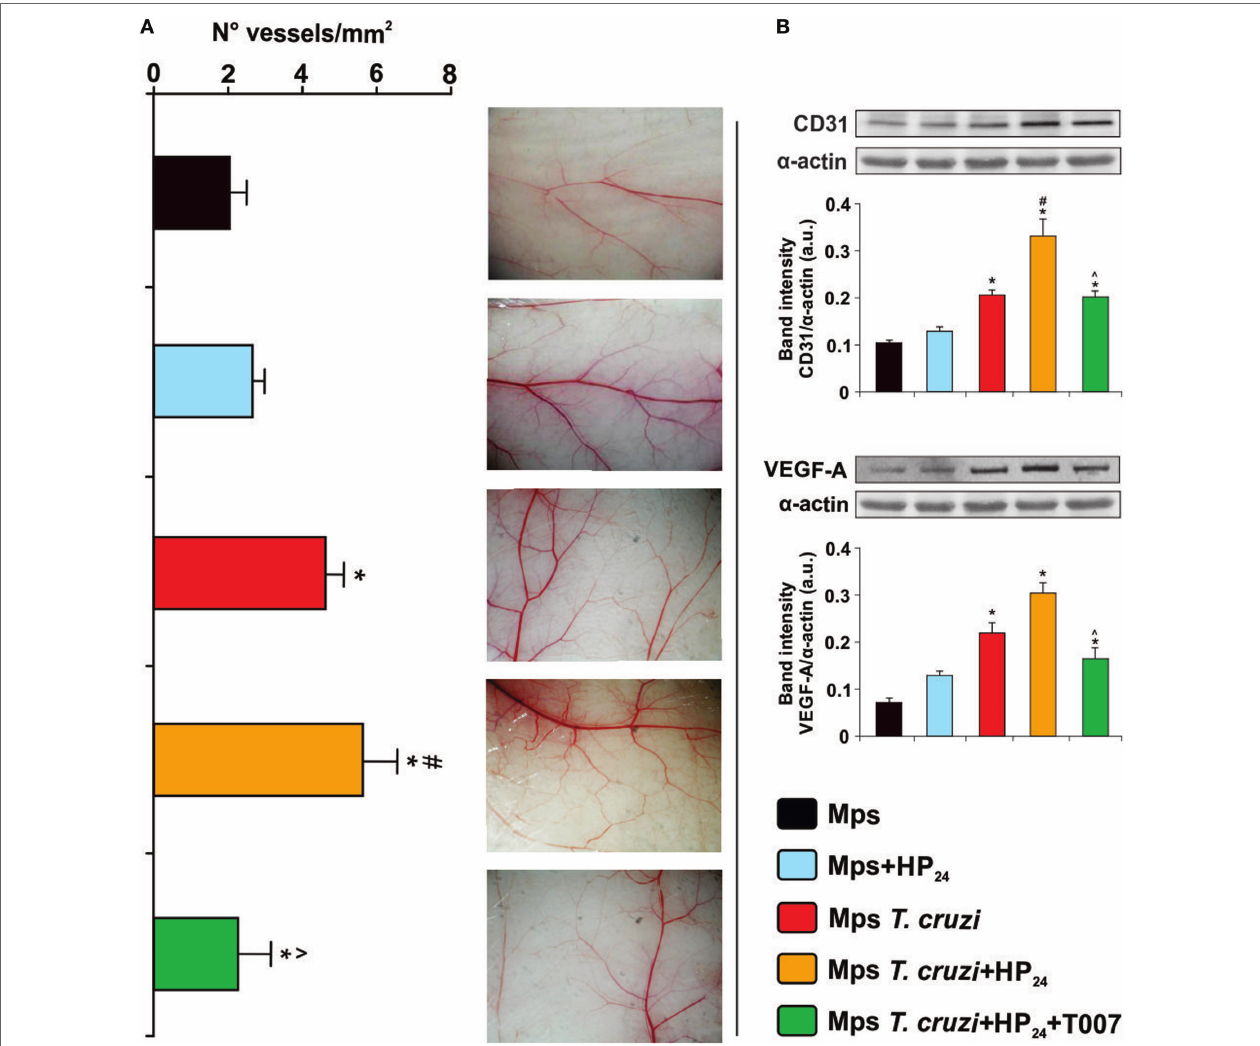
FigUre 4 | Participation of HP 24 in macrophage-induced angiogenesis. (a) Macrophage-induced angiogenesis in mice was determined in vivo by quantification of newly formed vessels in the skin. Peritoneal macrophages from different groups were pretreated with the peroxisome proliferator-activated receptor gamma antagonist T0070907 and treated with HP 24 . Then, the cells were harvested and adjusted to 2 × 10 5 cells/ml. One-tenth milliliters of the cell suspension was inoculated by intradermal route in both flanks of syngeneic normal mice. Five days after inoculation, recipient mice were sacrificed, the inner layer of the skin exposed, and photographs were acquired. Images were projected on a reticular screen to count the number of vessels per square millimeters. Angiogenesis was quantified as the vessel density, calculated as the total number of vessels divided by the total number of squares. (B) CD31 and Vascular endothelial growth factor A (VEGF-A) expression were determined by Western blot with a specific antibody. Anti-CD31 and anti-VEGF-A-specific antibody were used. Protein levels were normalized against α -actin. Results are mean band intensity ± SEM for three independent experiments (five mice per group). * P < 0.05 vs. uninfected mice macrophages, # P < 0.05 vs. Trypanosoma cruzi -infected mice macrophages . ^ P < 0.05 vs. HP 24 -treated macrophages from T. cruzi -infected mice. Mps,